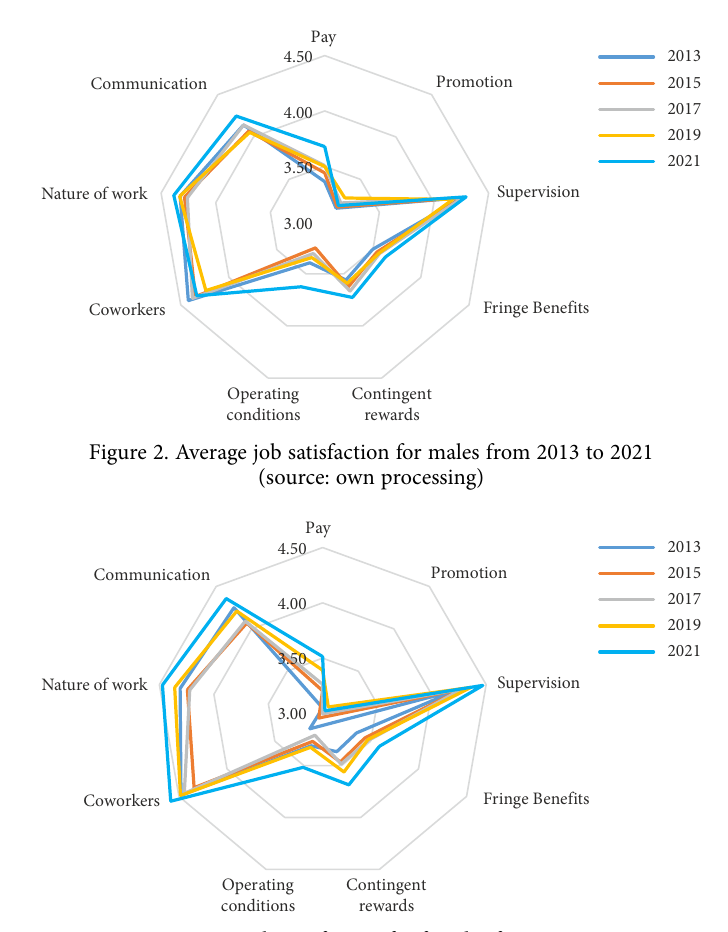
Figure 3. Average job satisfaction for females from 2013 to 2021 (source: own